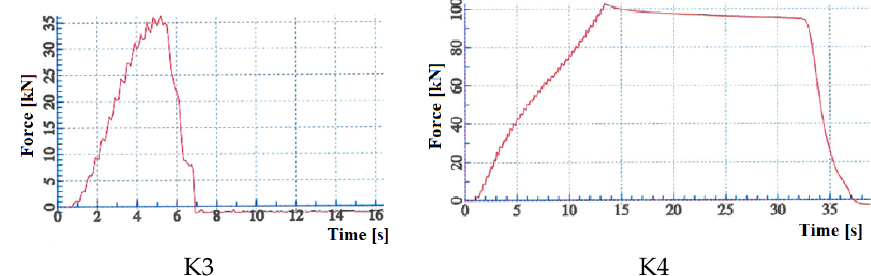
Figure 16. Load-time curve for tested K3 and K4 anchor.